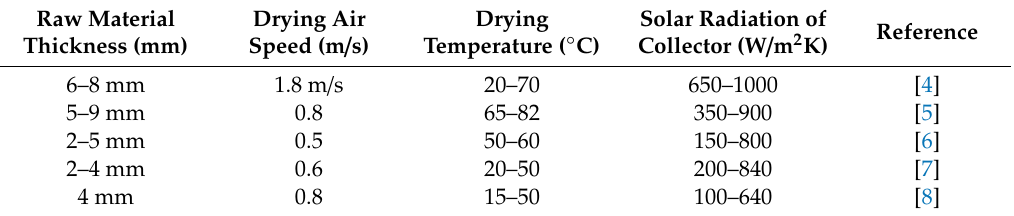
Table 1. Some studies related to drying apples using solar dryer in the